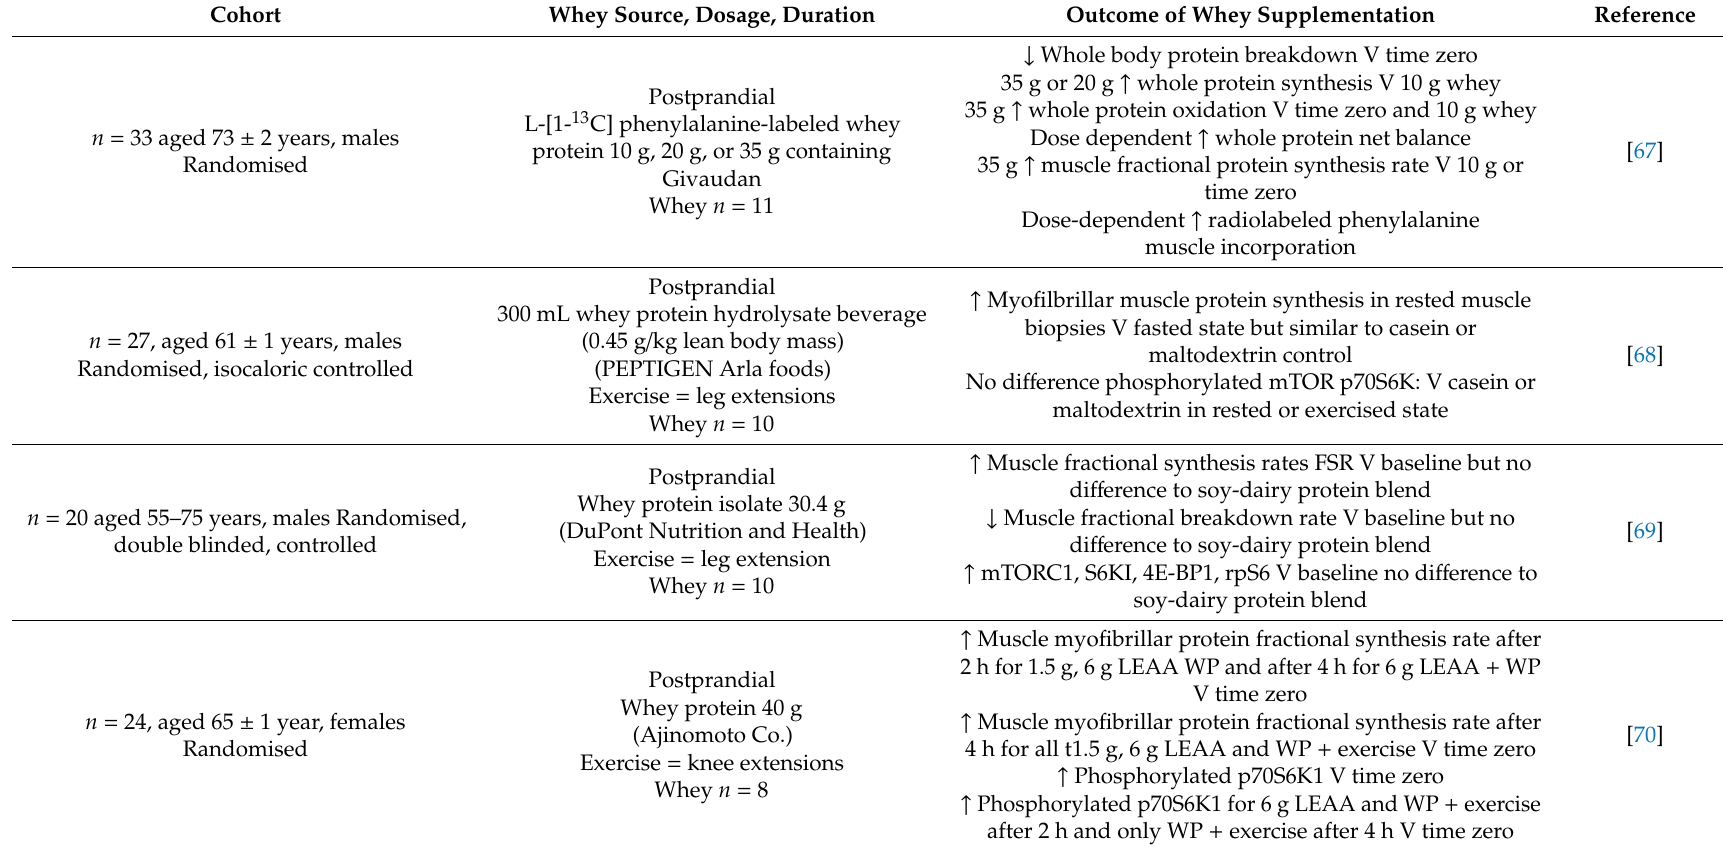
Table 3. Postprandial trials in the older adult with whey intervention. mTOR: mammalian target of rapamycin; FSR: fractional synthesis rate; LEAA: leucine essential amino acid; WP: whey protein; * power calculation to determine number of subjects was